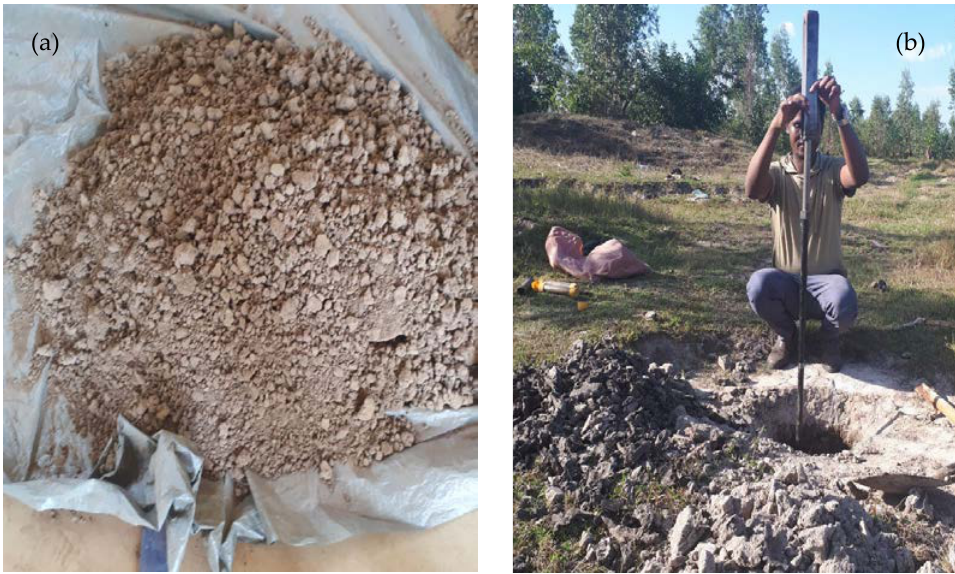
Figure 3. Photos of samples under different conditions ( a ) disturbed sample after air-dried ( b ) obtaining an undisturbed soil sample in the field.